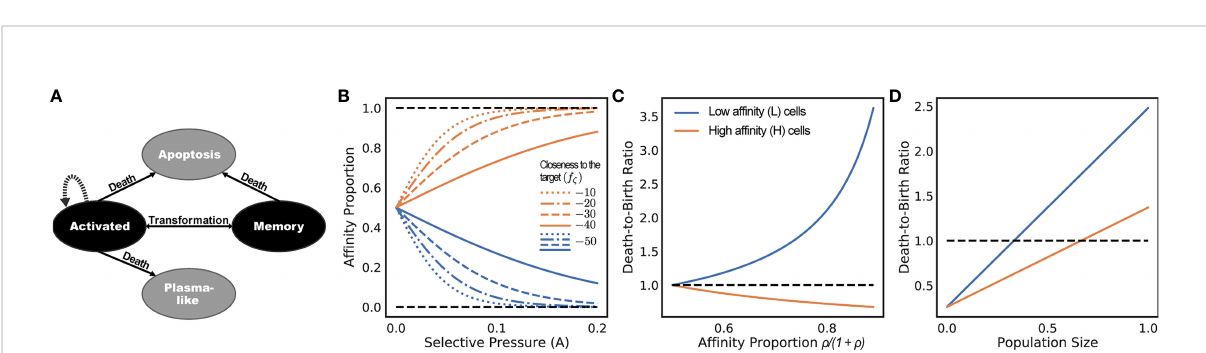
FIGURE 2 (A) States of cells and transitions during infected stage. Only states colored black are modeled. Transitions to states colored gray are treated as death events. (B-D) Consider a population of activated B cells where all cells have one of two sequences: L (low) or H (high). Let r be the ratio of af fi nity of H-type cells to L-type cells, and let the af fi nity proportion be the total af fi nity of a cell type over the total af fi nity (i.e., r / 1 + r for H and 1 / 1 + r for L). (B) The af fi nity proportion as a function of the selective pressure A when the sequence closeness to the target f z (.) is kept fi xed for L and varies for (H). (C) the ratio of death rate to birth rate as a function of af fi nity proportion of H cells, fi xing the population size to the carrying capacity. (D) Ratio of death rate to birth rate as a function of the population size normalized by the carrying capacity, fi xing r = 2. All other parameters set to defaults (Table 1). The selective pressure A and the level of binding control the portion of af fi nity taken up by better sequences (B) , which controls the growth of the cell type (C) , which is also a function of the total population size (D)